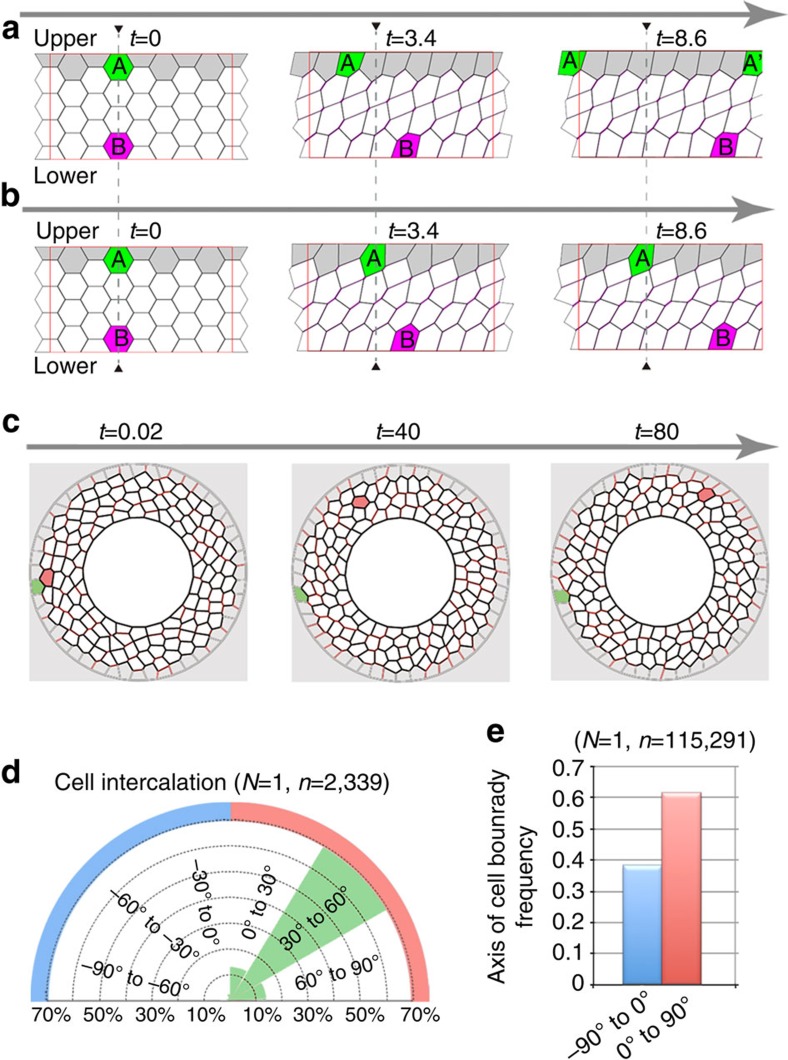
Numerical simulation of collective cell movement.(a,b) A directional dependence of the contraction forces on cell boundaries is assumed, in which cell boundaries inclining to the right have the largest contraction forces. The thickness of the magenta segments indicates the strength of the forces. As a guide, two cells are coloured magenta and green, and their original positions are indicated by black triangles and broken lines. The cells at the upper layer of the virtual epidermis are coloured grey. Numerical simulation of the condition in which the frictional coefficients at the upper and lower surfaces, denoted by μupper and μlower, respectively, are equal (μupper=μlower=1.0) (a). Simulation of the condition in which μupper=100.0 and μlower=1.0 (b). The cells are mobile in both cases, although the whole sheet moves in one direction only in b. (c) Numerical simulation, from the present model reproducing the in vivo situation. We applied much greater friction on the outer (A7) border, μA7=100.0, than on the other vertices, μi=1.0. Cell boundaries are represented by lines ranging from black (lower tension) to red (higher tension). As a guide, two cells are coloured red and green. The outermost borders of the A8a and A8p are represented by the inner circle, and the A7 epidermis is indicated by the grey region. (d) Rose diagrams representing the percentage of cell intercalation axes at 30° intervals of angle θ in the virtual cells in silico (illustrated in c). (e) PCC was observed in silico. Frequency of cell boundaries with angle θ in the range −90° to 0° or 0° to 90° with respect to the AP axis in silico (demonstrated in c). Number of trials, N; number of cell boundaries, n (d,e).